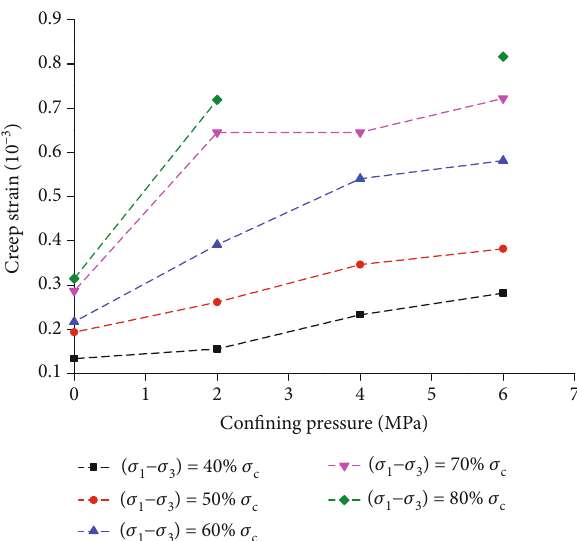
Figure 17: Curves of the creep strain versus the con fi ning pressure after 9 freeze-thaw cycles for various stress levels.